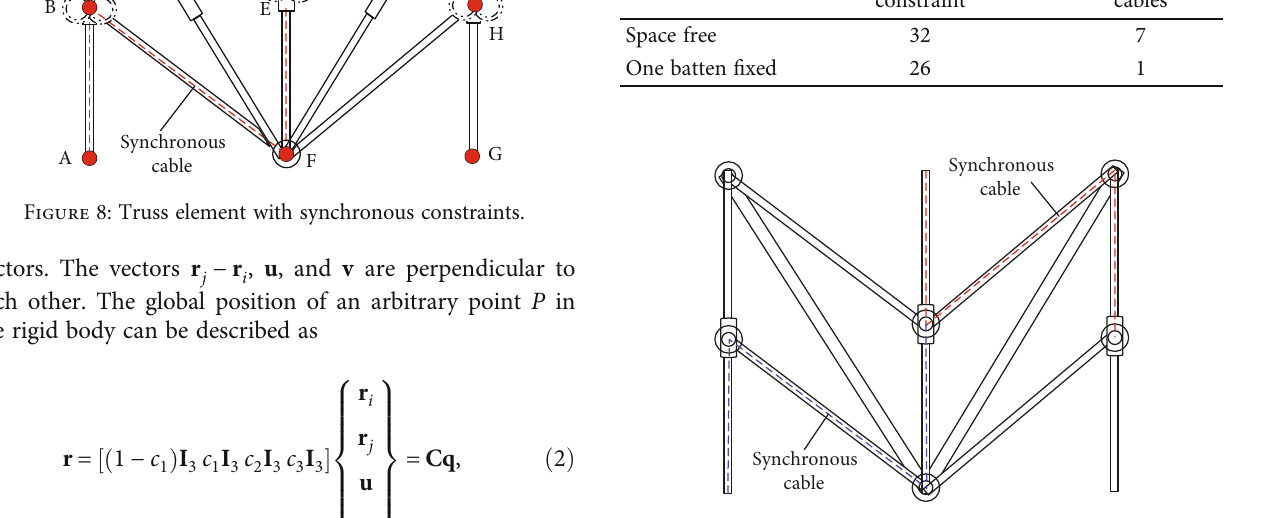
Figure 9: Truss element with synchronous cables